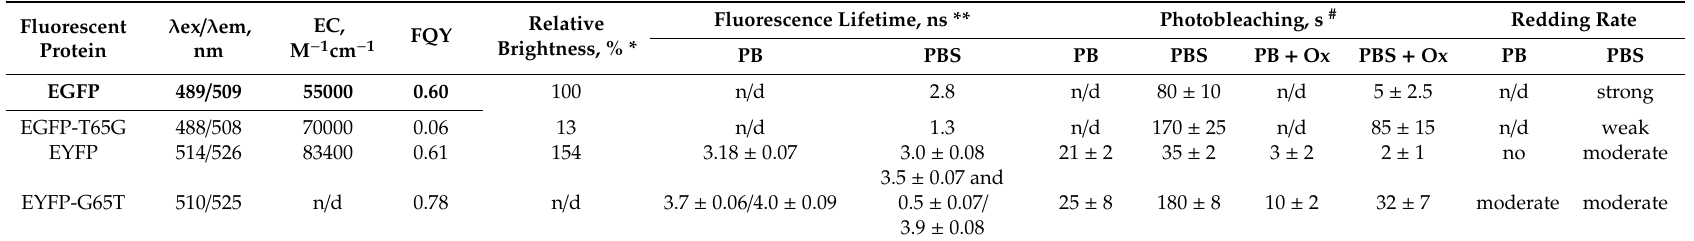
Table 1. Fluorescent properties of EGFP, EYFP, and their mutants, EGFP-T65G and